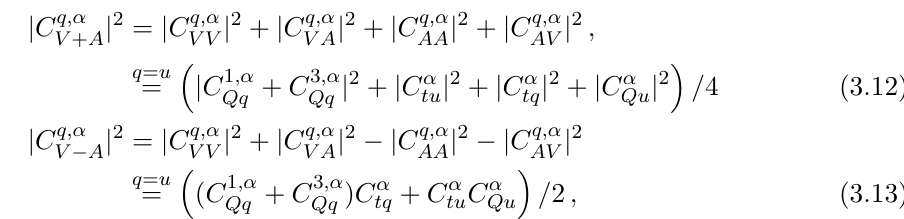
of the two qg ! t (cid:22) tq 2